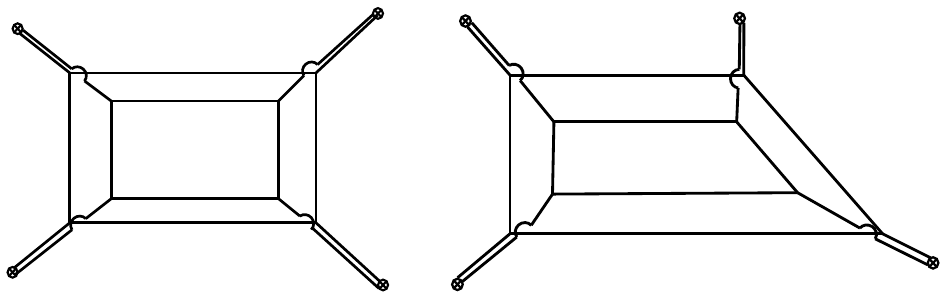
Figure 4 . Fivebrane web configuration of Sp(2) gauge theory with massless antisymmetric hypermultiplet in Type IIB theory where the left-panel represents θ = 0 while the right-panel illustrates θ = π